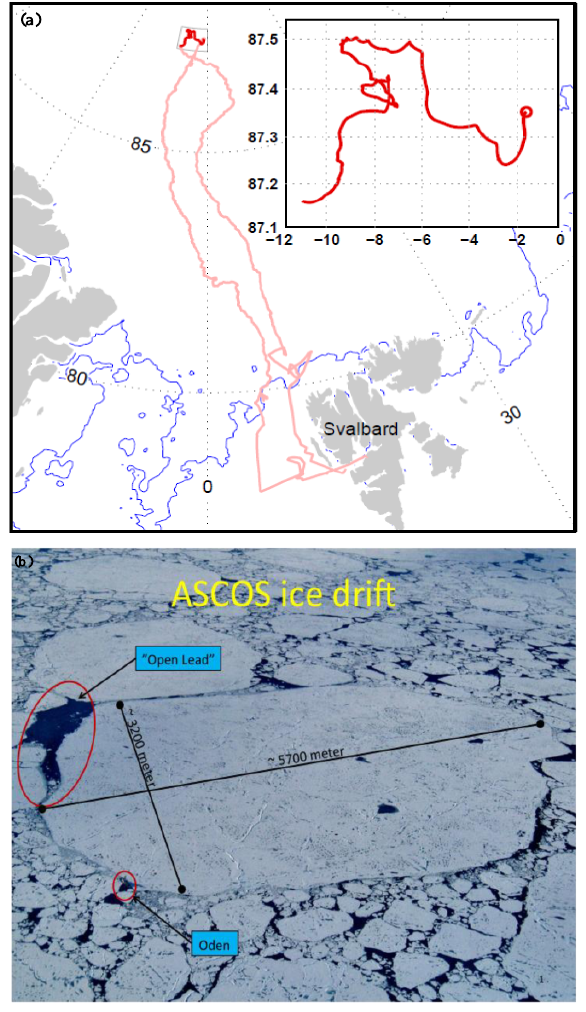
Fig. 1. (a) Map of the ASCOS cruise track (pink) with the ice-drift period highlighted (red, and inset area indicated) and shown in de- tail (inset, ∼ 87oN, ∼ 1–11oW)), with the start of the drift marked by the circle. The ice edge (blue line) is shown for the start of the drift period on 12 August 2008. (b) The ice floe, on which the AS- COS measurements took place, with the icebreaker R/V Oden and the open lead sampling site are